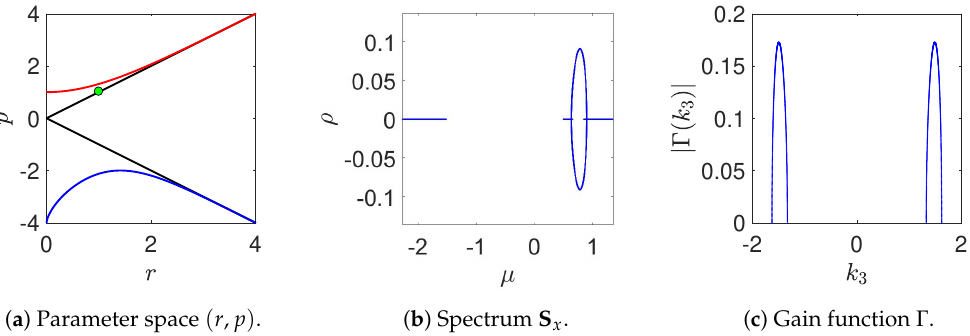
Figure 4. The spectrum S x 2G 0B 1L and gain function Γ for r = 1, p = 1.025 (defocussing).